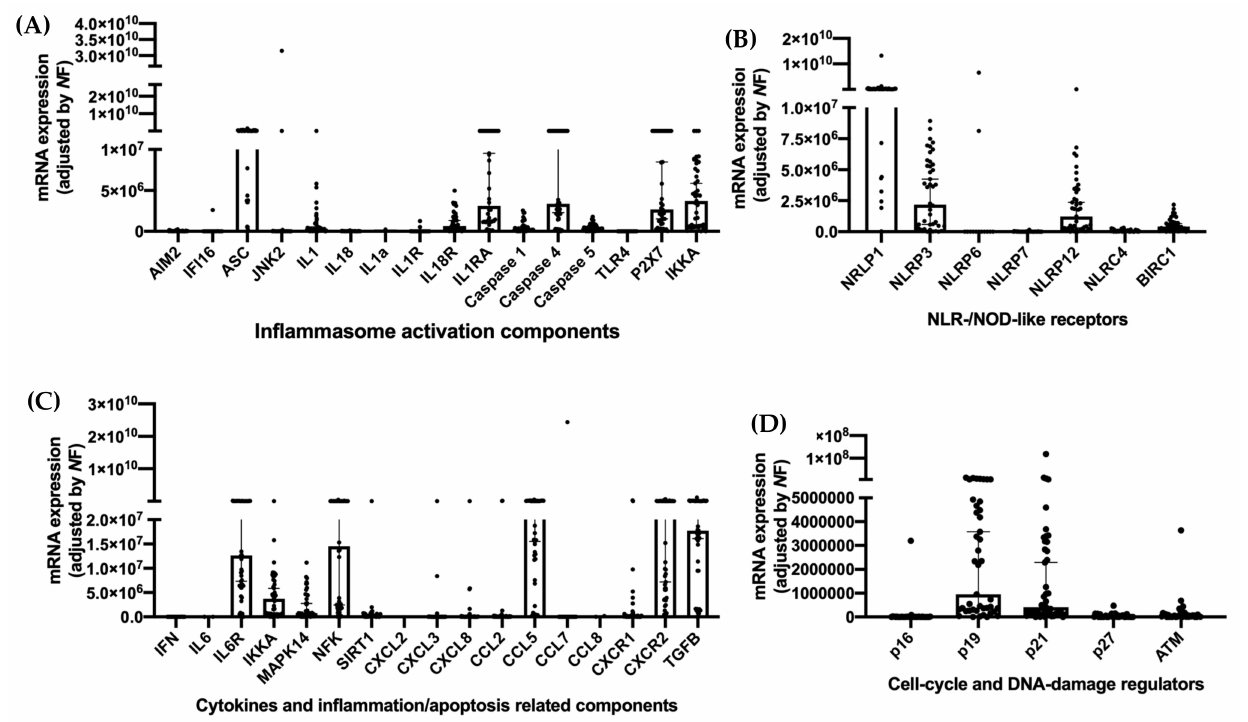
Figure 1. mRNA expression of key components of the inflammasome system. ( A ) Activation components; ( B ) NLR/NOD-like receptors; ( C ) Cytokines and inflammation/apoptosis related components; ( D ) Cell-cycle and DNA damage